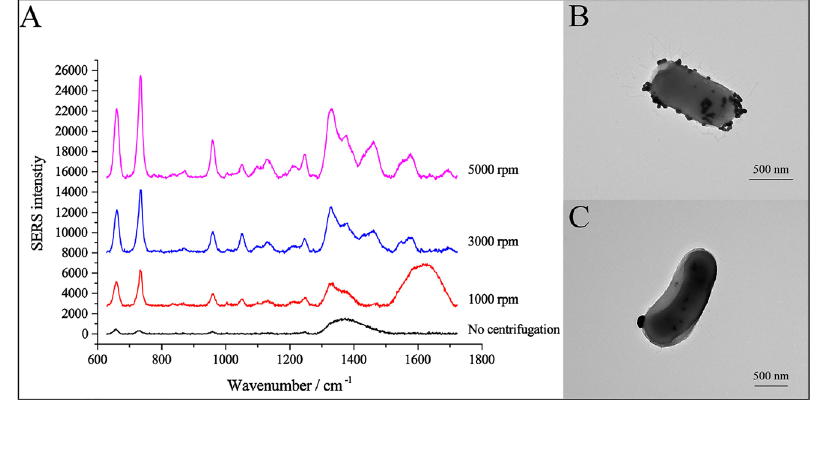
micrograph of E. coli cell with AgNPs after micrograph of E. coli cell with AgNPs without centrifugation [51].